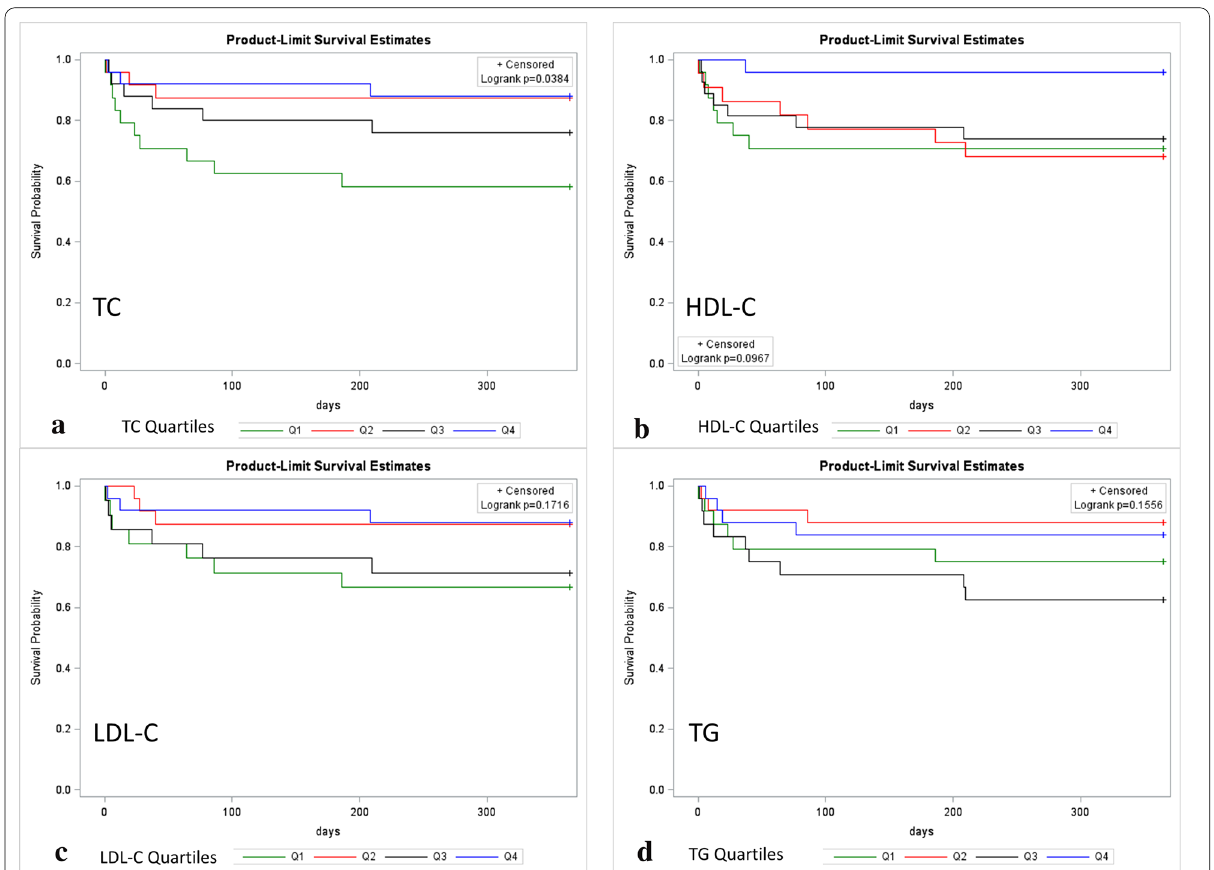
Fig. 2 : Kaplan–Meier survival curves over 1 year after sepsis are presented by quartiles for a TC (total cholesterol), b high-density lipoprotein-cholesterol (HDL-C), c low-density lipoprotein-cholesterol (LDL-C), d triglycerides (TG), e HDL inflammatory index (HII), f paraoxonase-1 (PON-1), g apolipoprotein A-I (ApoA-I), and h myeloperoxidase